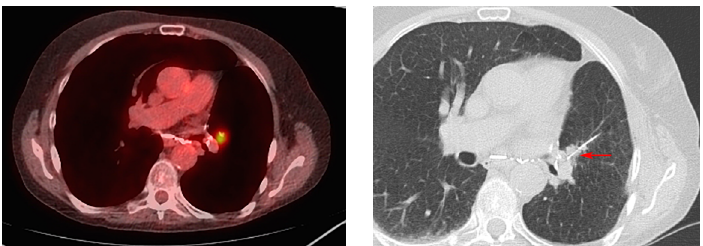
Fig 1. Example of likelihood of adequacy score 1 (low). (A) Fused PET/CT image showinga left lung nodulethat though FDG avid is small, deep in emphysematous lung (better seen in b), and adjacent to the pulmonary artery. (B) Arrow points to needlein left lung nodule.